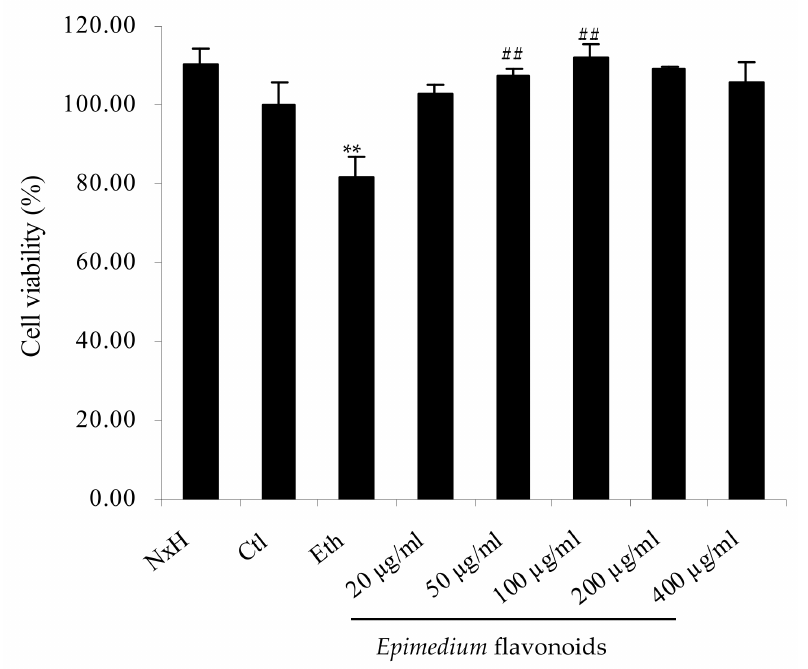
Figure 2. Protective effects of Epimedium flavonoids on RA-treated SH-SY5Y cells under ethanol exposure. Ctl: control group; Eth: ethanol group; NxH: naloxone hydrochloride group; 20 µ g/mL, 50 µ g/mL, 100 µ g/mL, 200 µ g/mL and 400 µ g/mL represent flavonoids group containing the corresponding concentrations of Epimedium flavonoids. Data were expressed as means of five replicates ( n = 5). **: p < 0.01 (versus control group); ## : p < 0.01 (versus ethanol